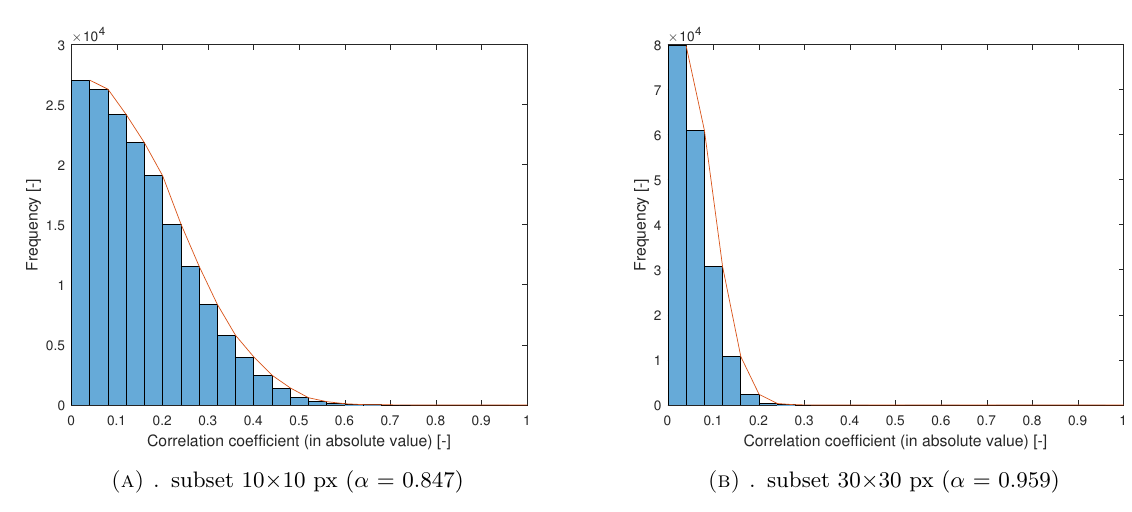
Figure 5. Distribution of correlation coefficient, fine spray pattern.